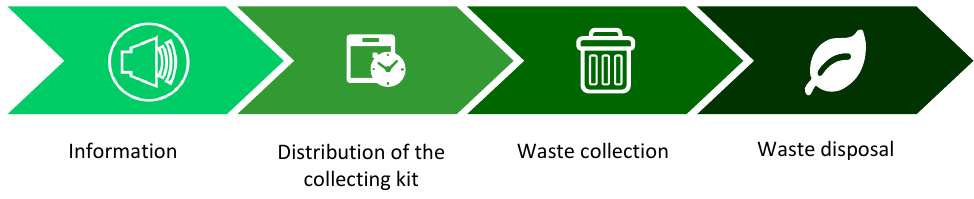
Figure 6: ASPEM Waste Management